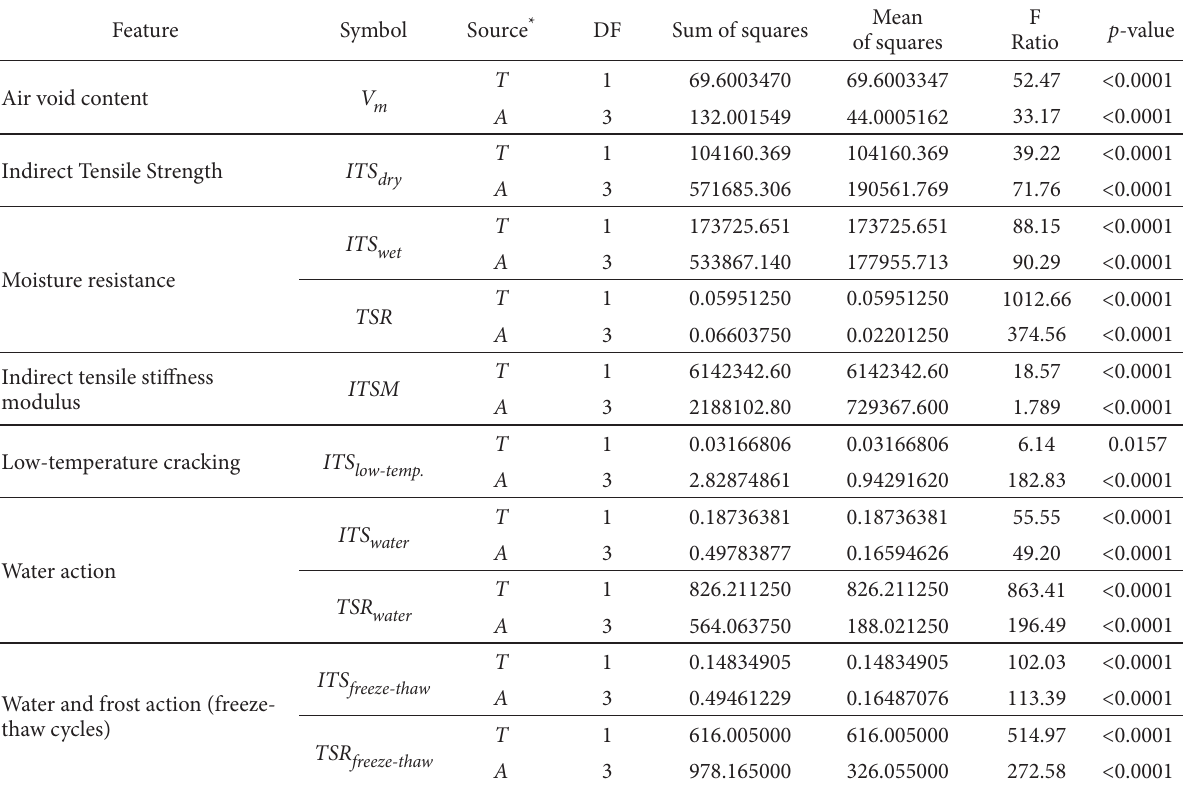
Table 4. Significant influence evaluation (two-way ANOVA) of the factors (type, amount) on tested features Feature Sum of squares